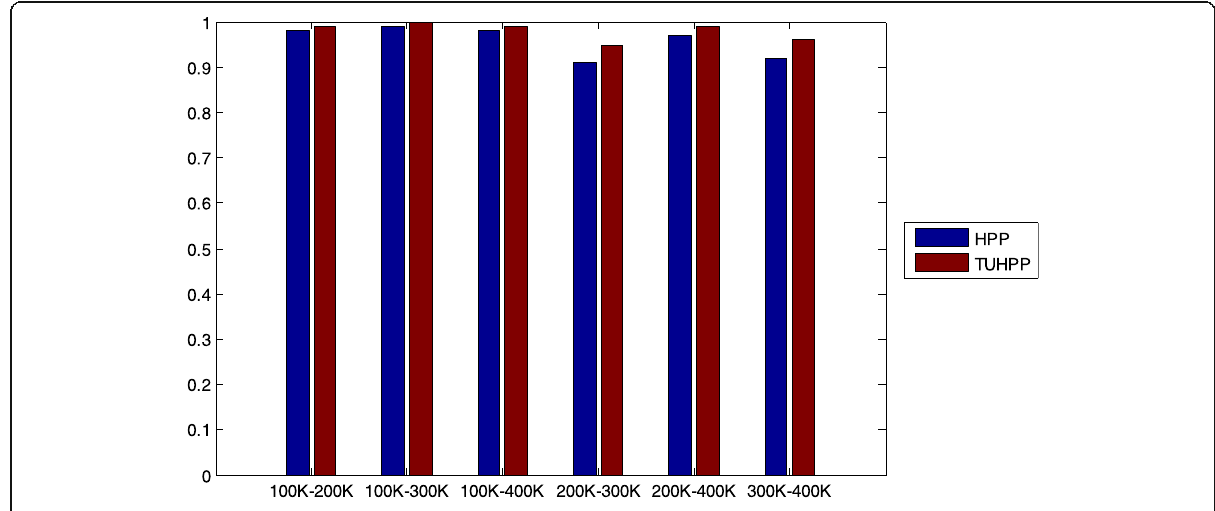
Fig. 8 The mean value (MEAN) of detection accuracy of HPP [14] and TUHPP